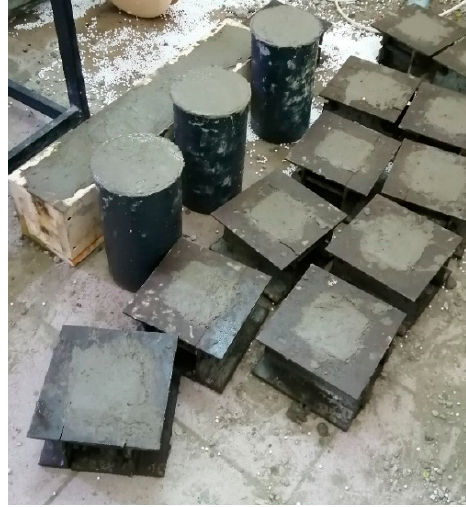
Figure 2. Concrete in